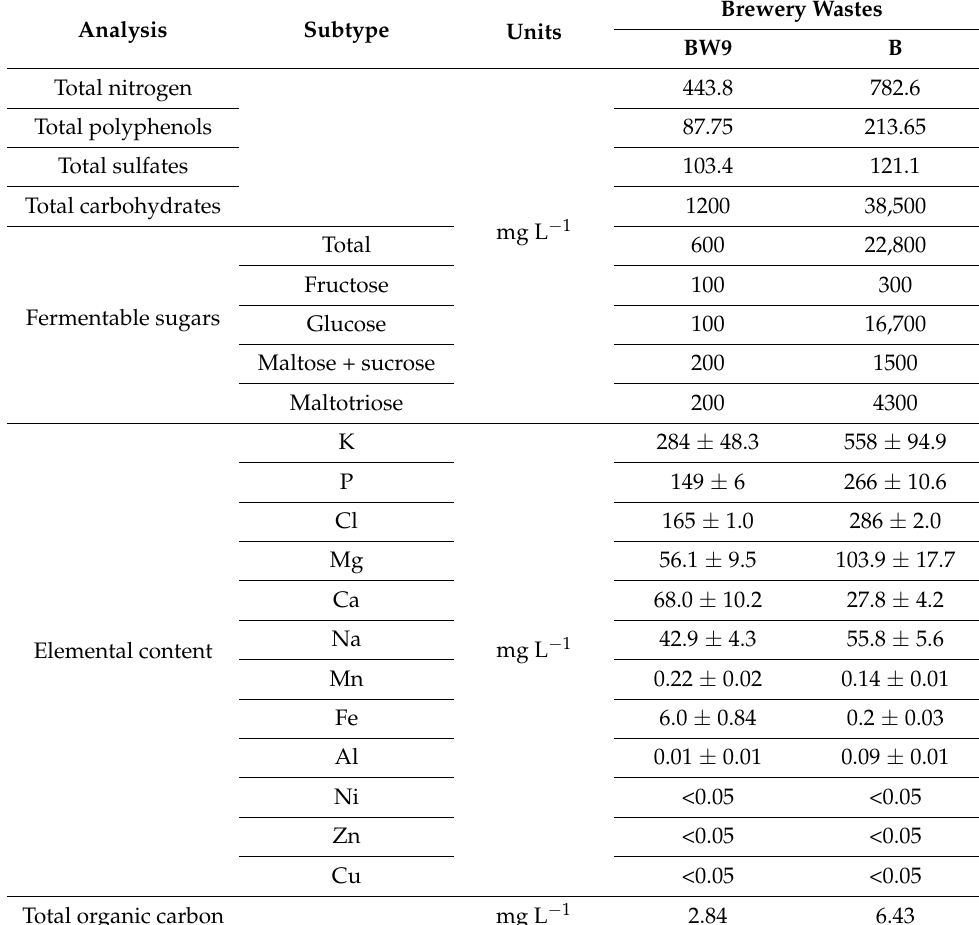
Table 1. Composition analysis of BW9 and